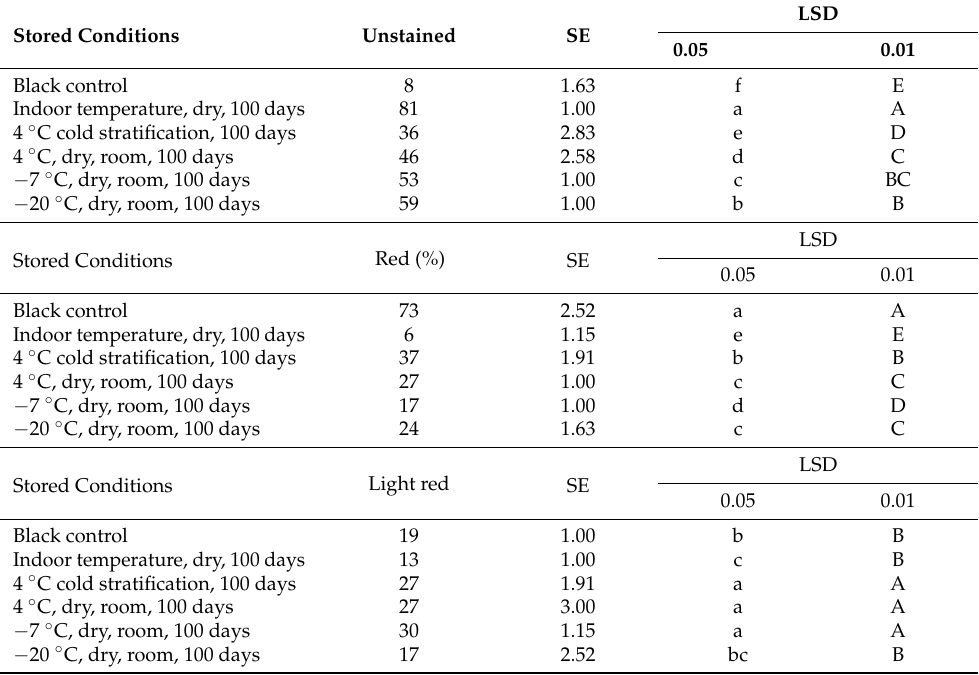
Note: unstained seeds indicated they were dead; Red indicated all of them can germinate; Light red presented seeds have weak germination vigor. The seed vigor (red in TTC) in the control and stored at 4 ◦ C in moist sand and at constant temperatures (4 ◦ C, − 7 ◦ C, or − 20 ◦ C) were 73, 37, 27, 24 and 6%,